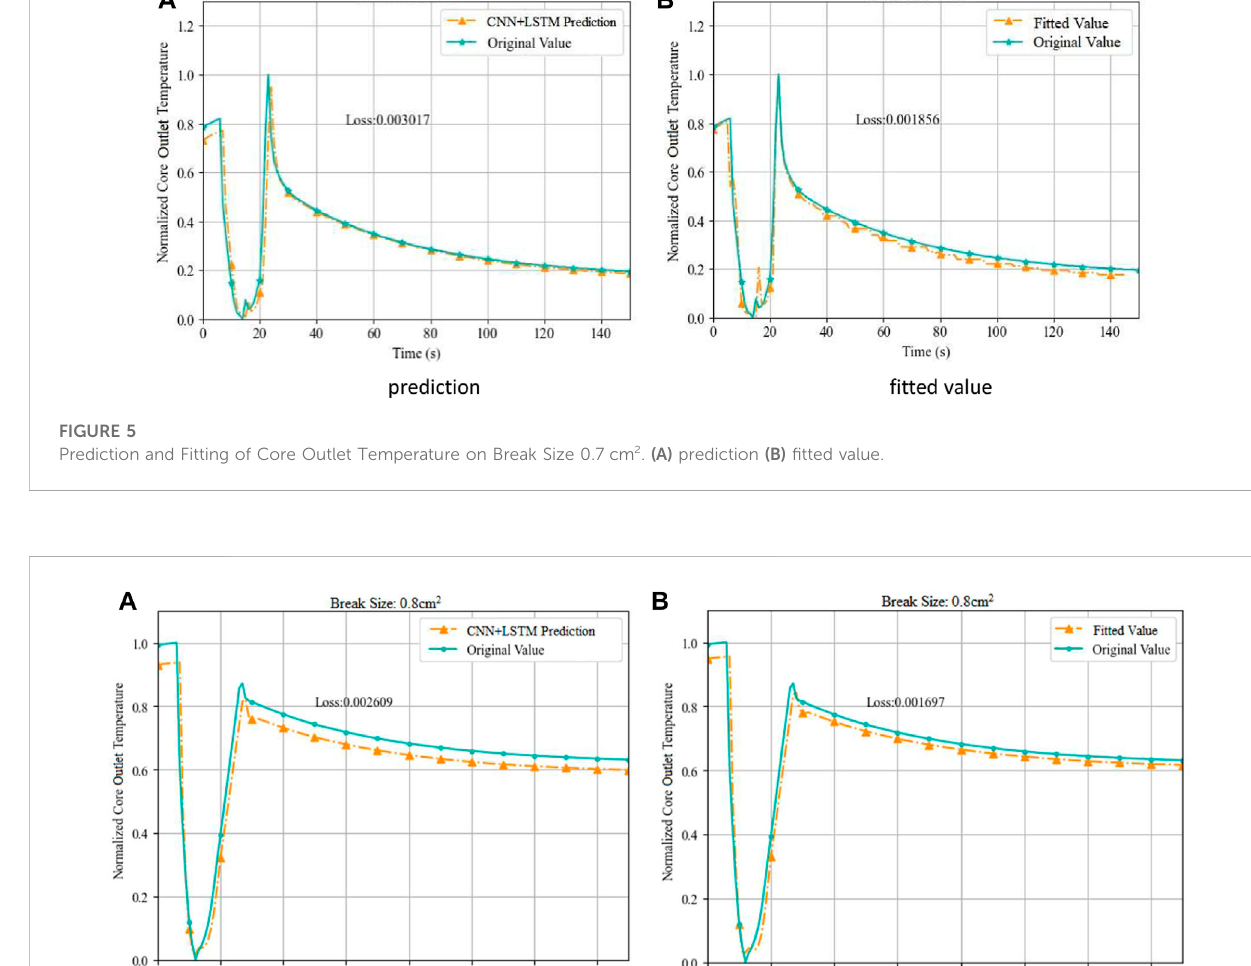
Frontiers in Energy